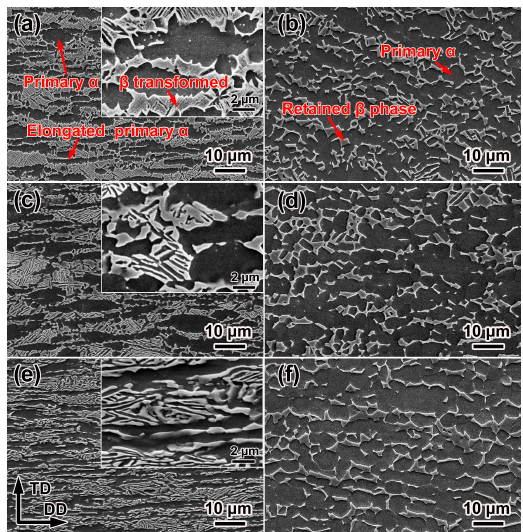
Figure 2. SEM micrographs of VT3-1 alloy after warm drawing and isothermal annealing: ( a ) as-received state; ( b ) as-received + isothermally annealed (IA) state; ( c ) 30% warm-drawn state; ( d ) 30% warm-drawn + IA state; ( e ) 60% warm-drawn state; ( f ) 60% warm-drawn + IA state. After isothermal annealing, the mean primary α grain sizes (along TD) of 0%, 30%, and 60%